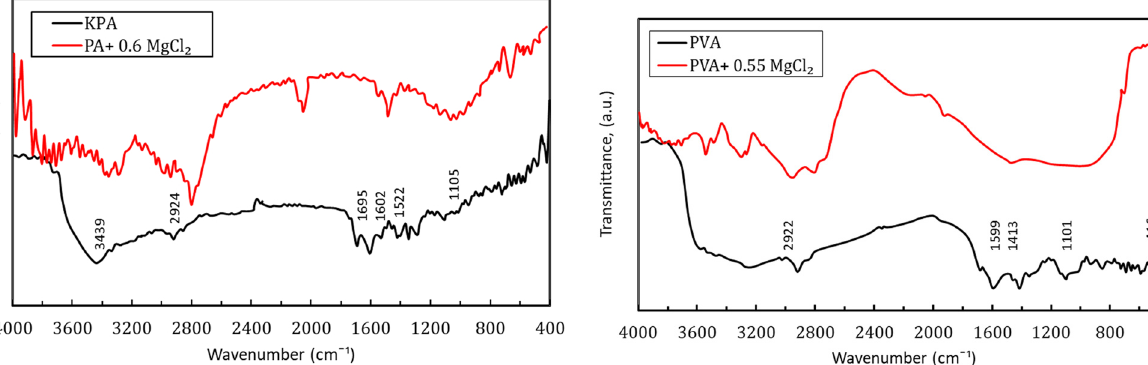
Figure 5: FTIR spectra of KPA and Mg - PA ( 0.6 g of MgCl 2 ) . Figure 6: FTIR spectra of PVA and Mg - PVA ( 0.55 g of MgCl 2 )